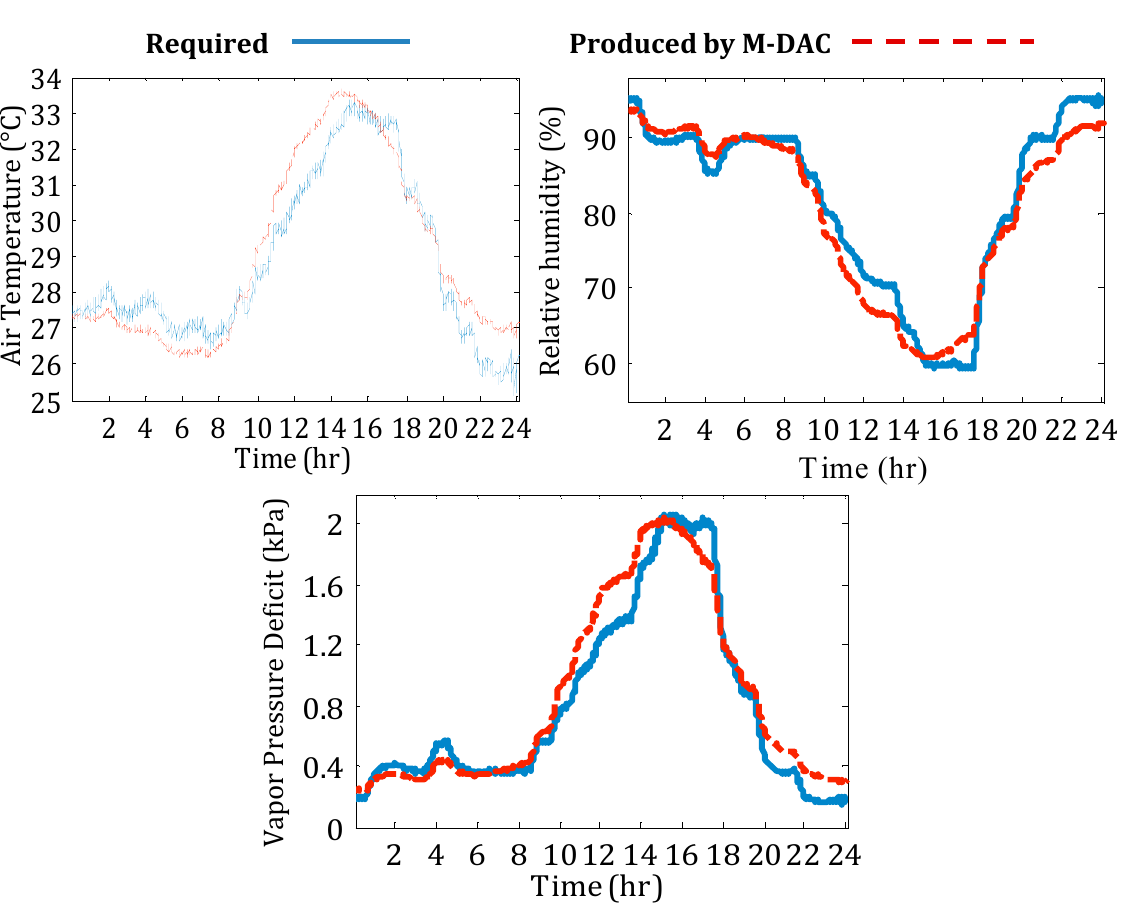
Figure 14. Validation of the performance of the proposed M-DAC with the OptDeg model for 24 h in greenhouse cultivation of tomato under vegetative to mature fruiting growth stages.